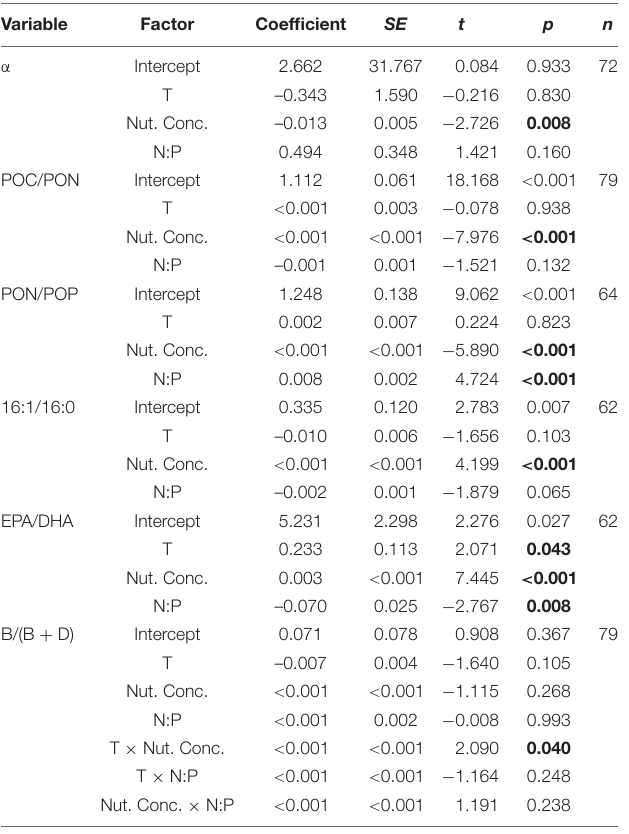
FIGURE 2 | The responses of the interaction coefficient α to temperature, N:P supply ratios and nutrient concentrations in the bicultures of Phaeodactylum tricornutum and Prorocentrum minimum . At α > 0 dinoflagellates have the competitive superiority, while diatoms have the competitive superiority at α < 0. There is no competitive superiority for either species at α = 0.